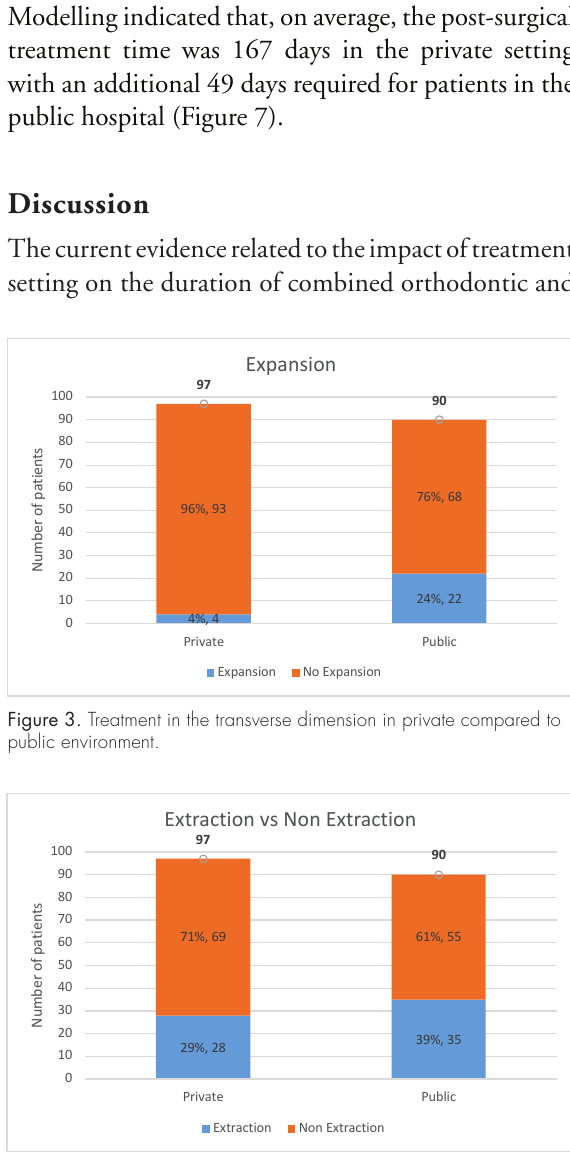
Figure 2. Surgical cases by skeletal Class in private compared to public environment.